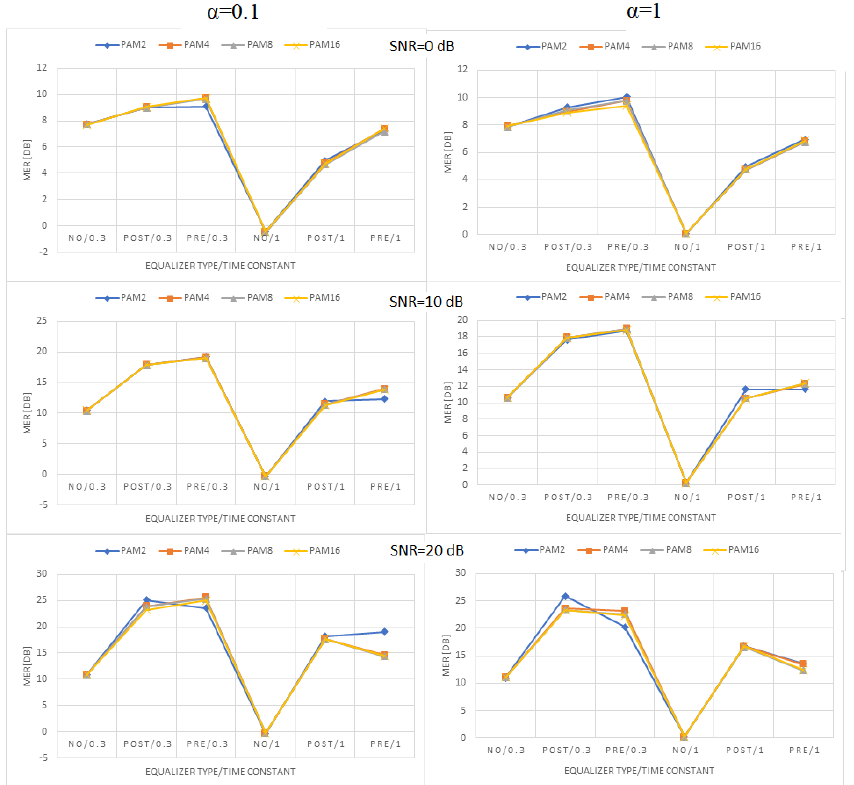
Figure 9. MER values obtained in the linear case ([1, 0, 0, 0]).